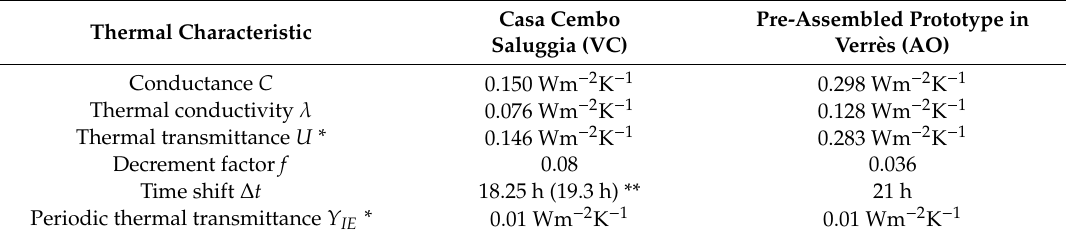
Table 4. Main results of the experimental campaigns and calculations on straw